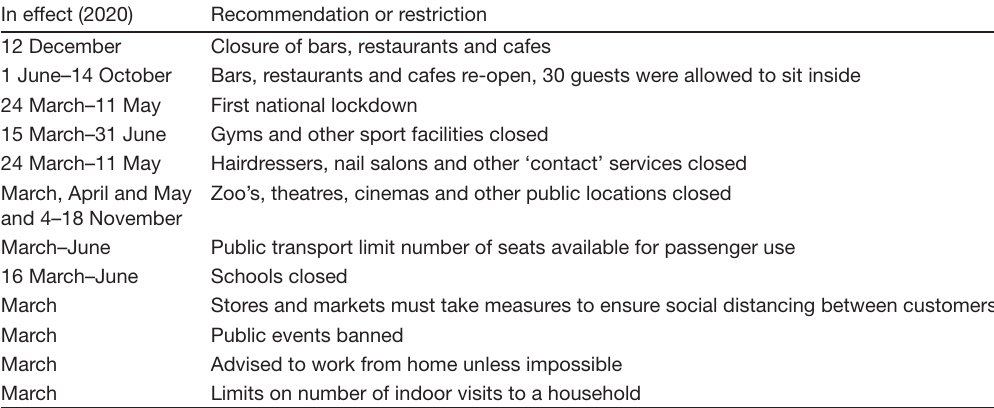
Table A4. List of recommendations and restrictions in The Netherlands during